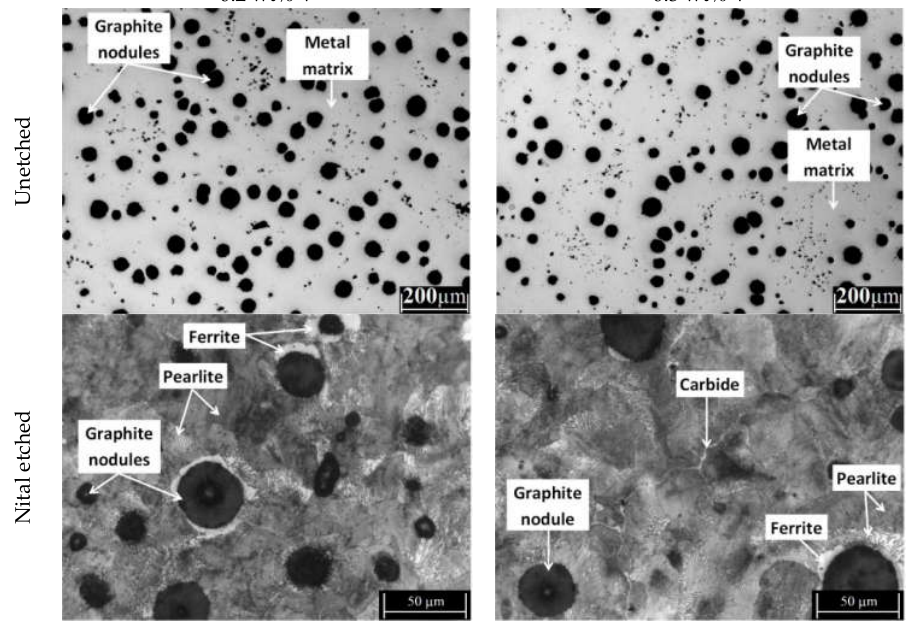
Figure 6. Microstructure at high magnifications for the DI low alloyed with V in unetched condition and etched with nital 3%.